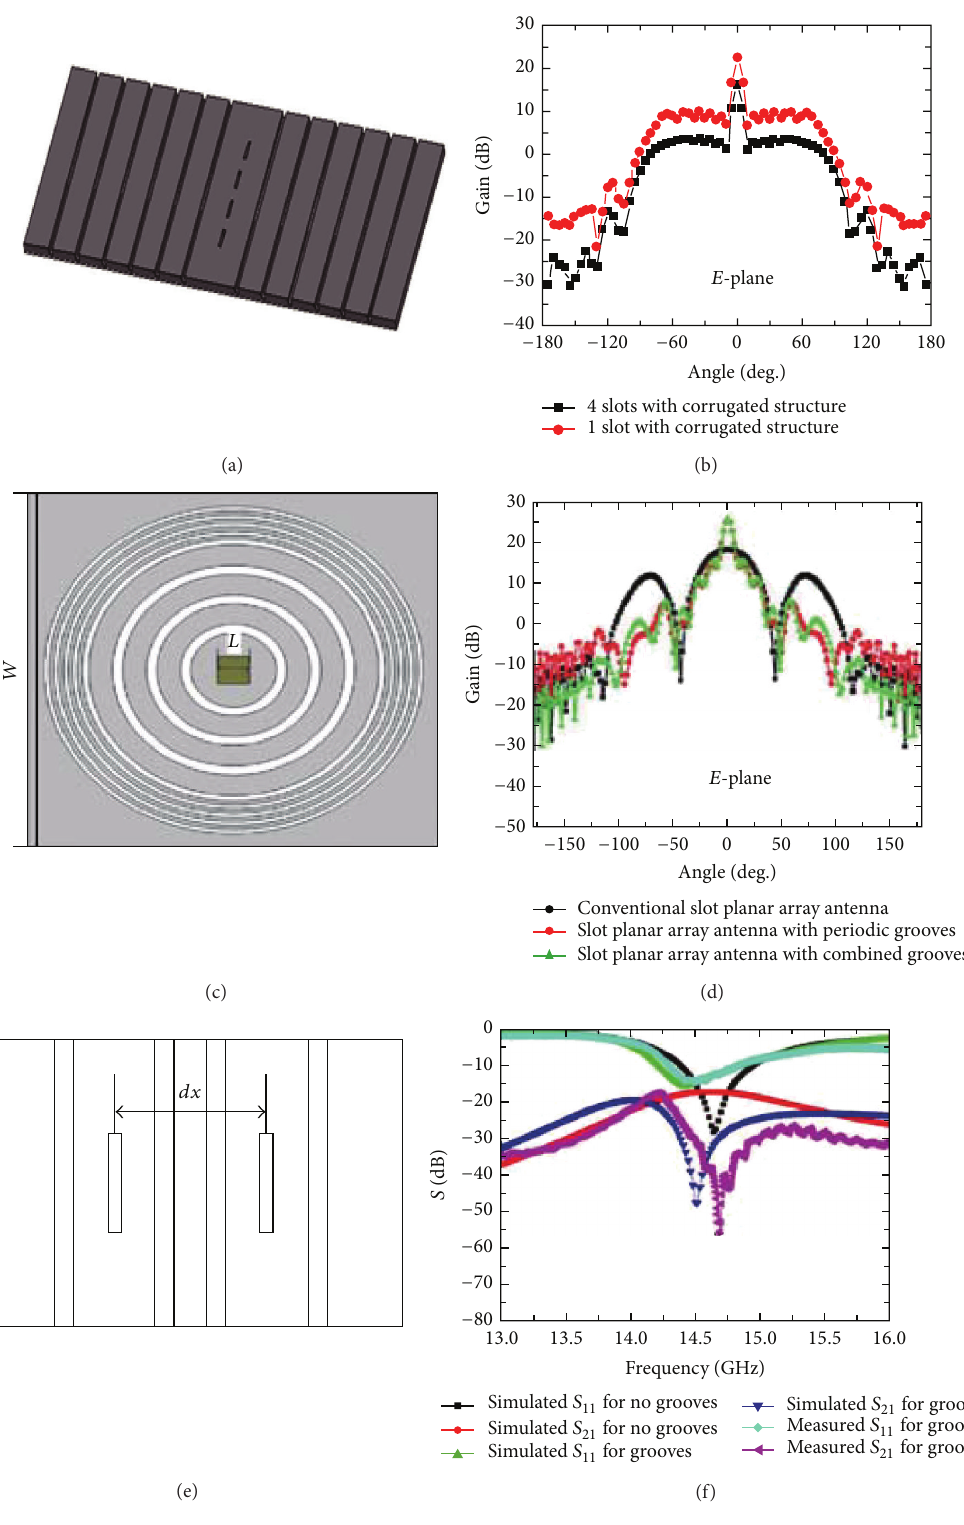
Figure 28: (a) Groove antennas based on slot array. (b) The 𝐸 -plane radiation pattern for the antenna in (a). (c) Patch antennas loaded with the groove structure. (d) The 𝐸 -plane radiation pattern for the antenna in (c). (e) Slot array antenna with low coupling. (f) Coupling efficiency of the antenna in (c). Figures are reproduced from